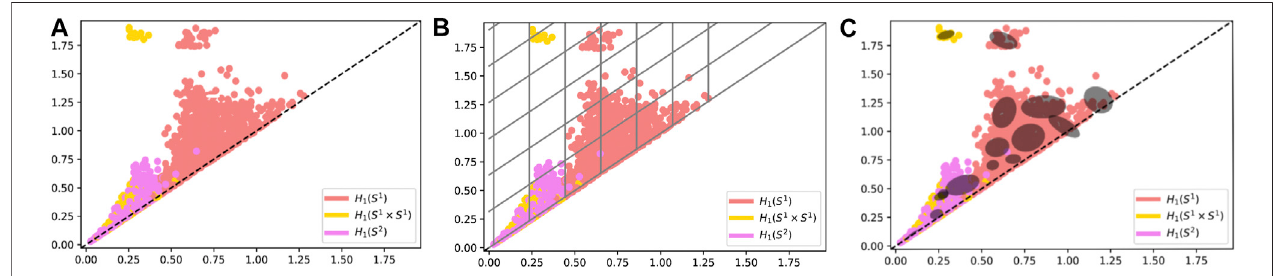
FIGURE 8 | (A) Persistence Diagrams (B) Persistence Diagrams with boundaries of the support function for Tent Features (C) Persistence Diagrams with boundaries of the support for Adaptive